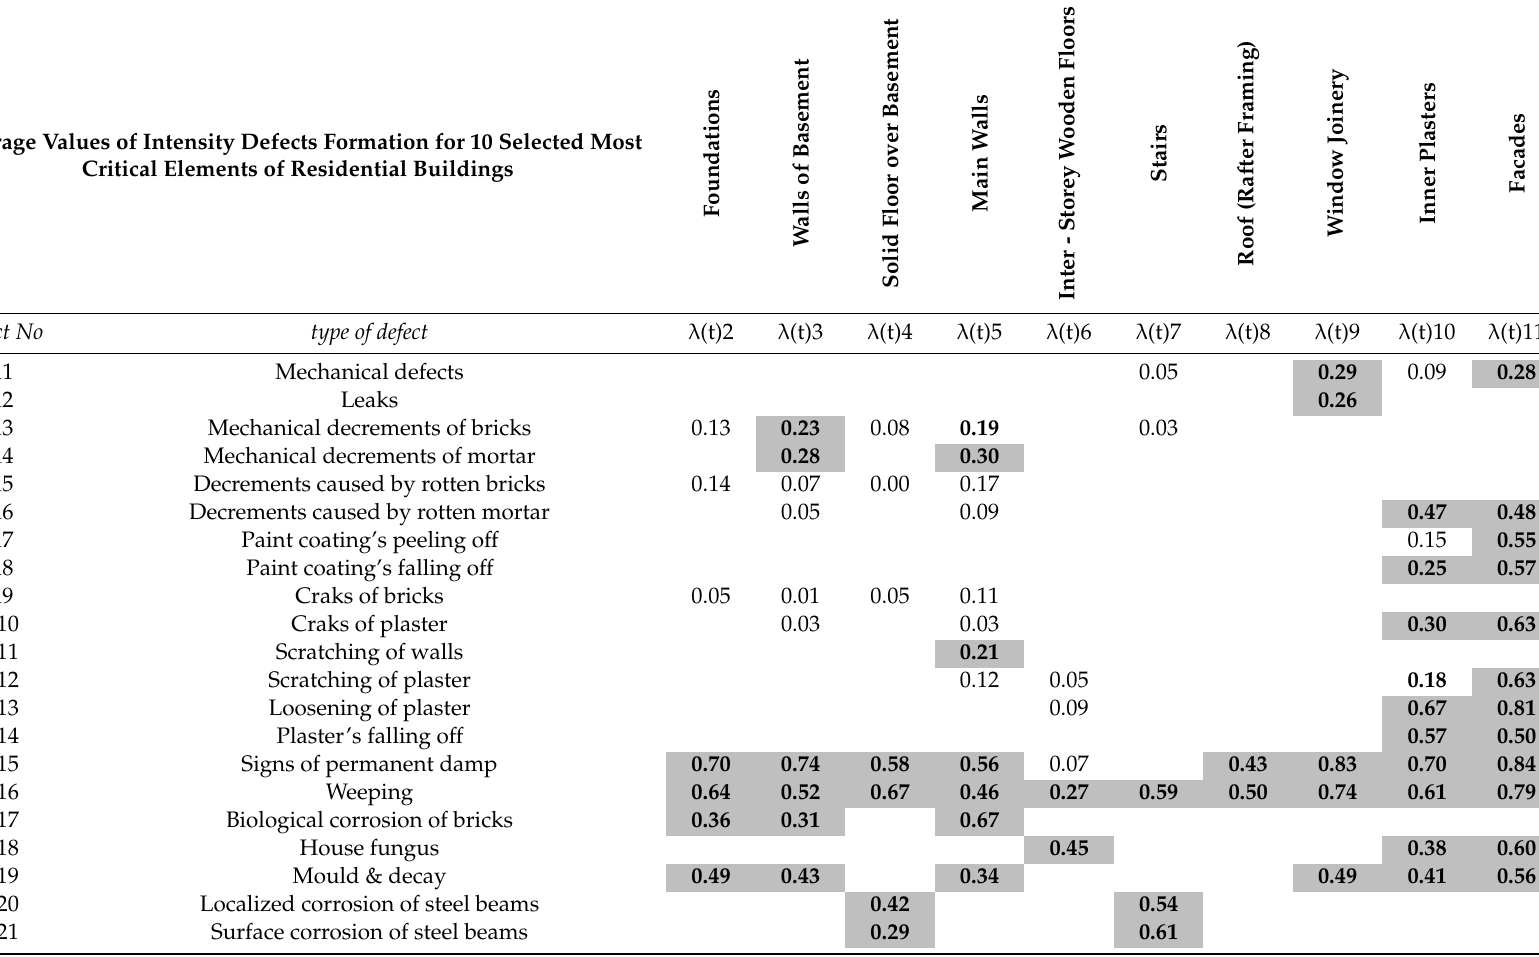
Table 1. Average values of the damage intensity function λ (t) for the ten most important elements of residential buildings.